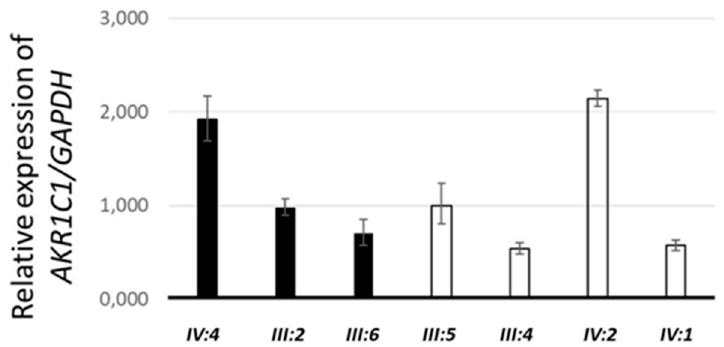
Figure 2. Relative expression of AKR1C1 in the blood of the affected (black) and healthy (white) family members.